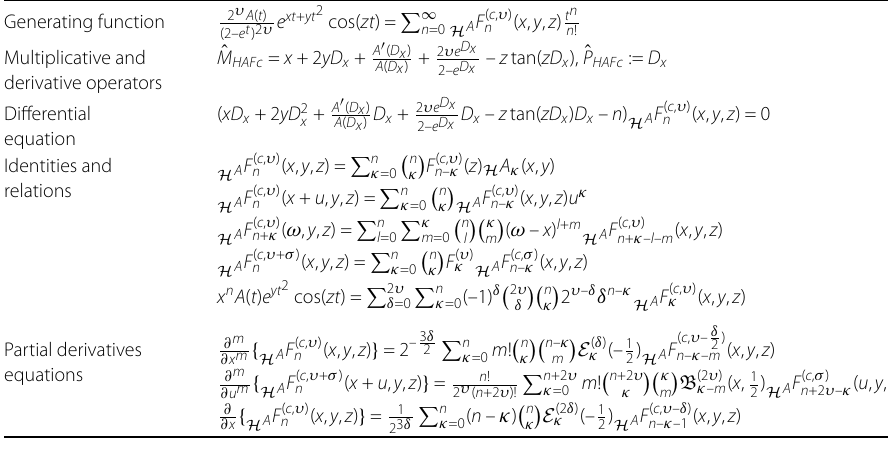
Table 9 Results for Generating function 2 Multiplicative and derivative